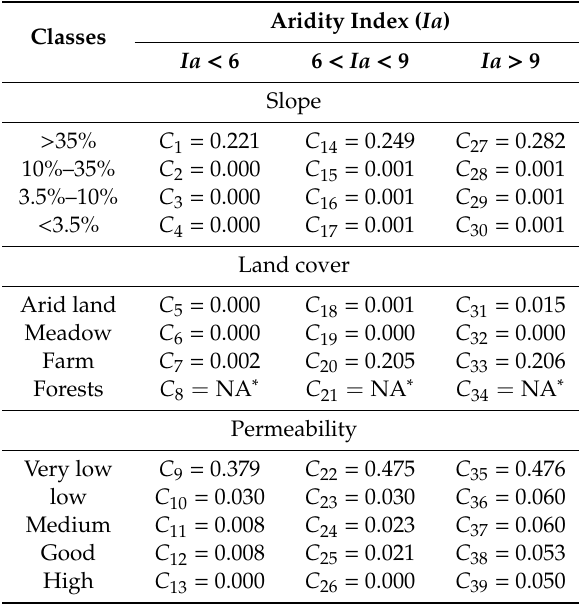
Table 6. Calibrated partial runo ff coe ffi cient of the Kennessey model.